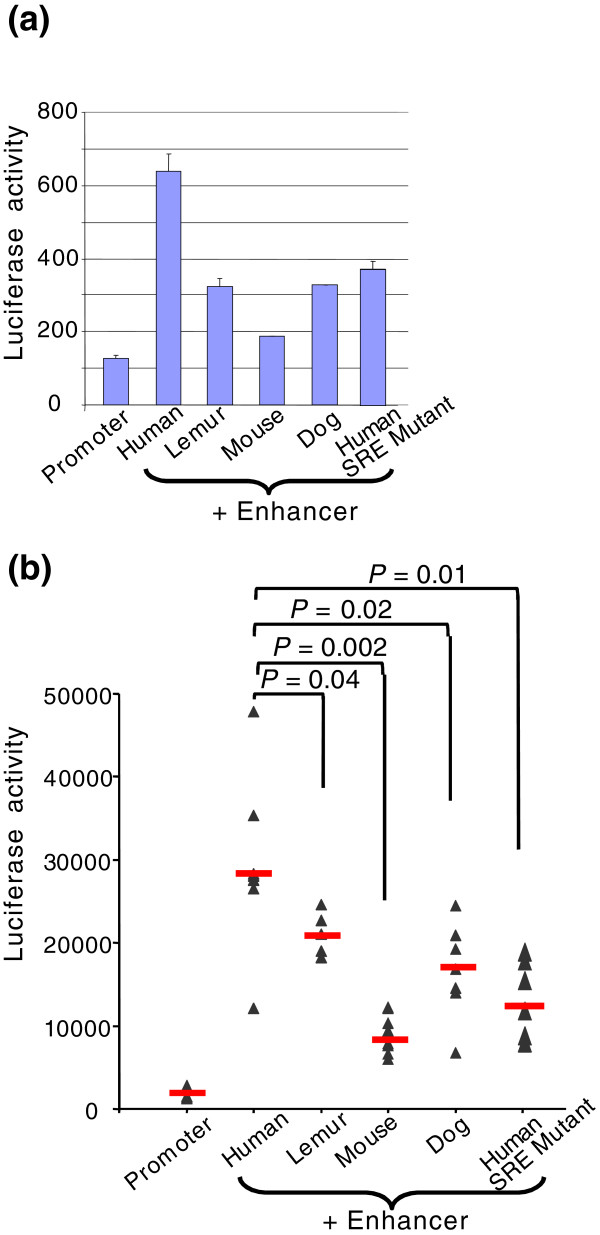
Human LDLR PS2 enhancer exhibits significantly higher activity than orthologous lemur, mouse, and dog enhancers. Luciferase assay analysis of (a) transient transfections into human 293T cells and (b) plasmid DNA transfer into mouse liver. The luciferase reporter constructs tested are either the LDLR promoter alone (promoter) or the promoter in combination with the LDLR PS2 enhancer from one of the indicated species. Error bars indicate standard deviation. 'SRE mutant' refers to the mutagenized human sterol regulatory element (SRE) with four point substitutions relative to the wild-type (WT) SRE (Figure 4a). Luciferase activity is reported in arbitrary units. Each triangle in panel b represents luciferase activity in an individual mouse. Red bars denote the median activity of each construct.